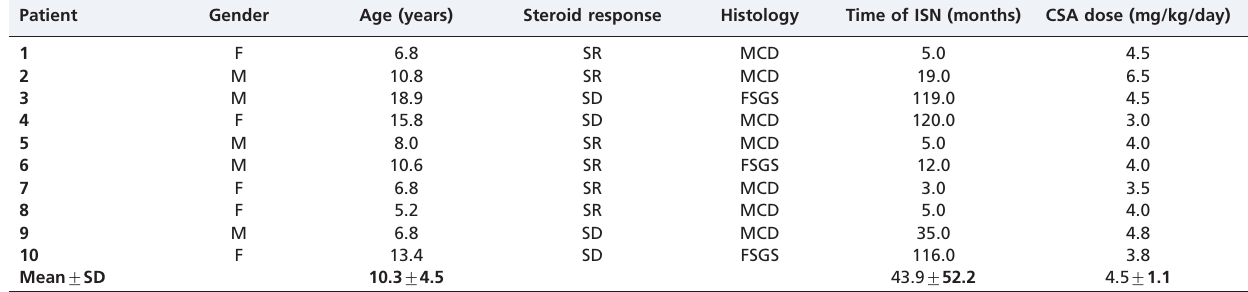
Table 1 - Characteristics of the 10 INS patients.